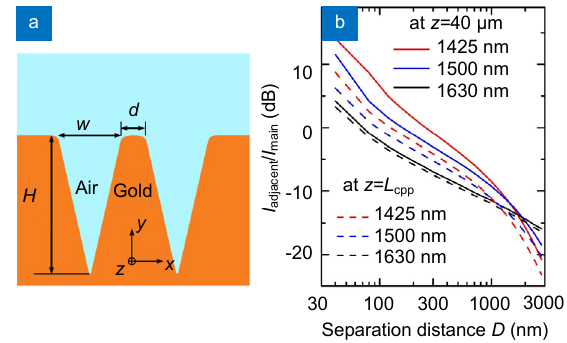
Fig. 2 | ( a ) The schematic of two adjacent parallel channel plasmon- polariton waveguides. ( b ) The crosstalk performance with specific parameters 27 .